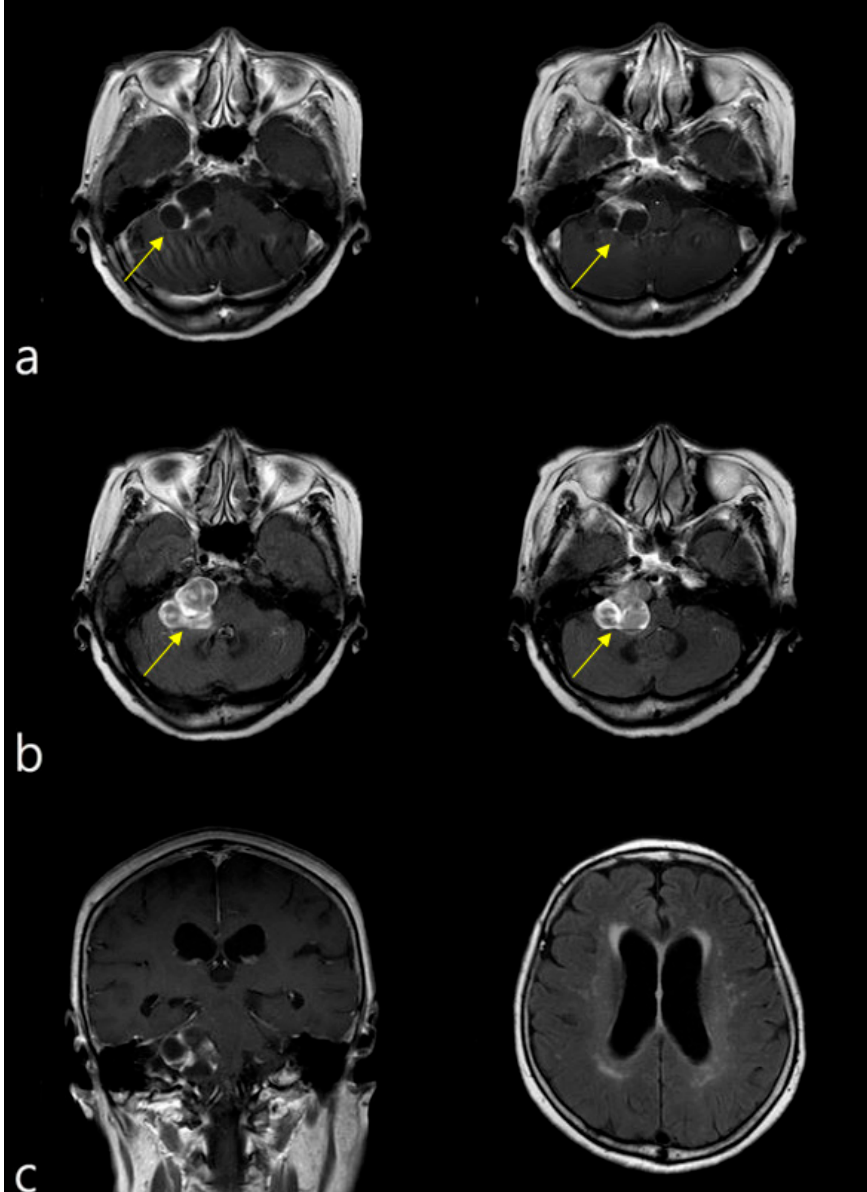
Figure 1. Brainstem magnetic resonance imaging (MRI). ( a ) T1-weighted enhanced imaging showing a well-margined, enhancing mass at the right cerebellopontine angle (3.4 × 2.7 cm), compatible with vestibular schwannoma (arrows). ( b ) T2-weighted MRI imaging, showing high signal intensity similar to CSF, demonstrating heterogeneous enhancement (arrows). ( c ) Image showing compression by the tumor mass of the right side of the brainstem, resulting in mild obstructive hydroceph- alus.